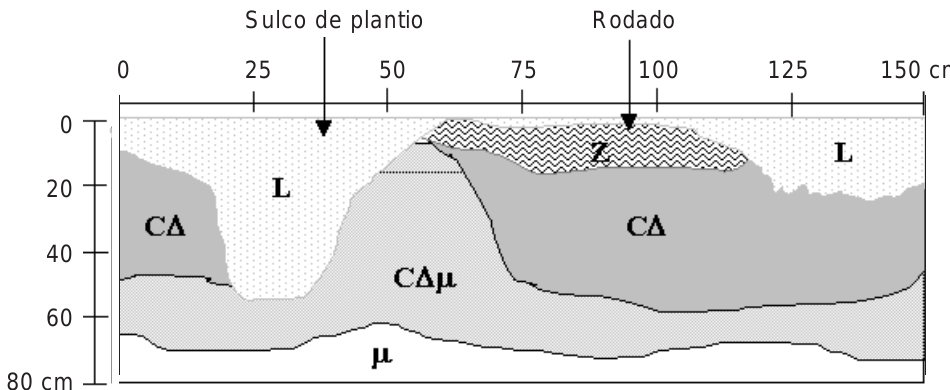
Figura 3. Perfil Cultural sob área de cana-de-açúcar em TRE (Igaraçu do